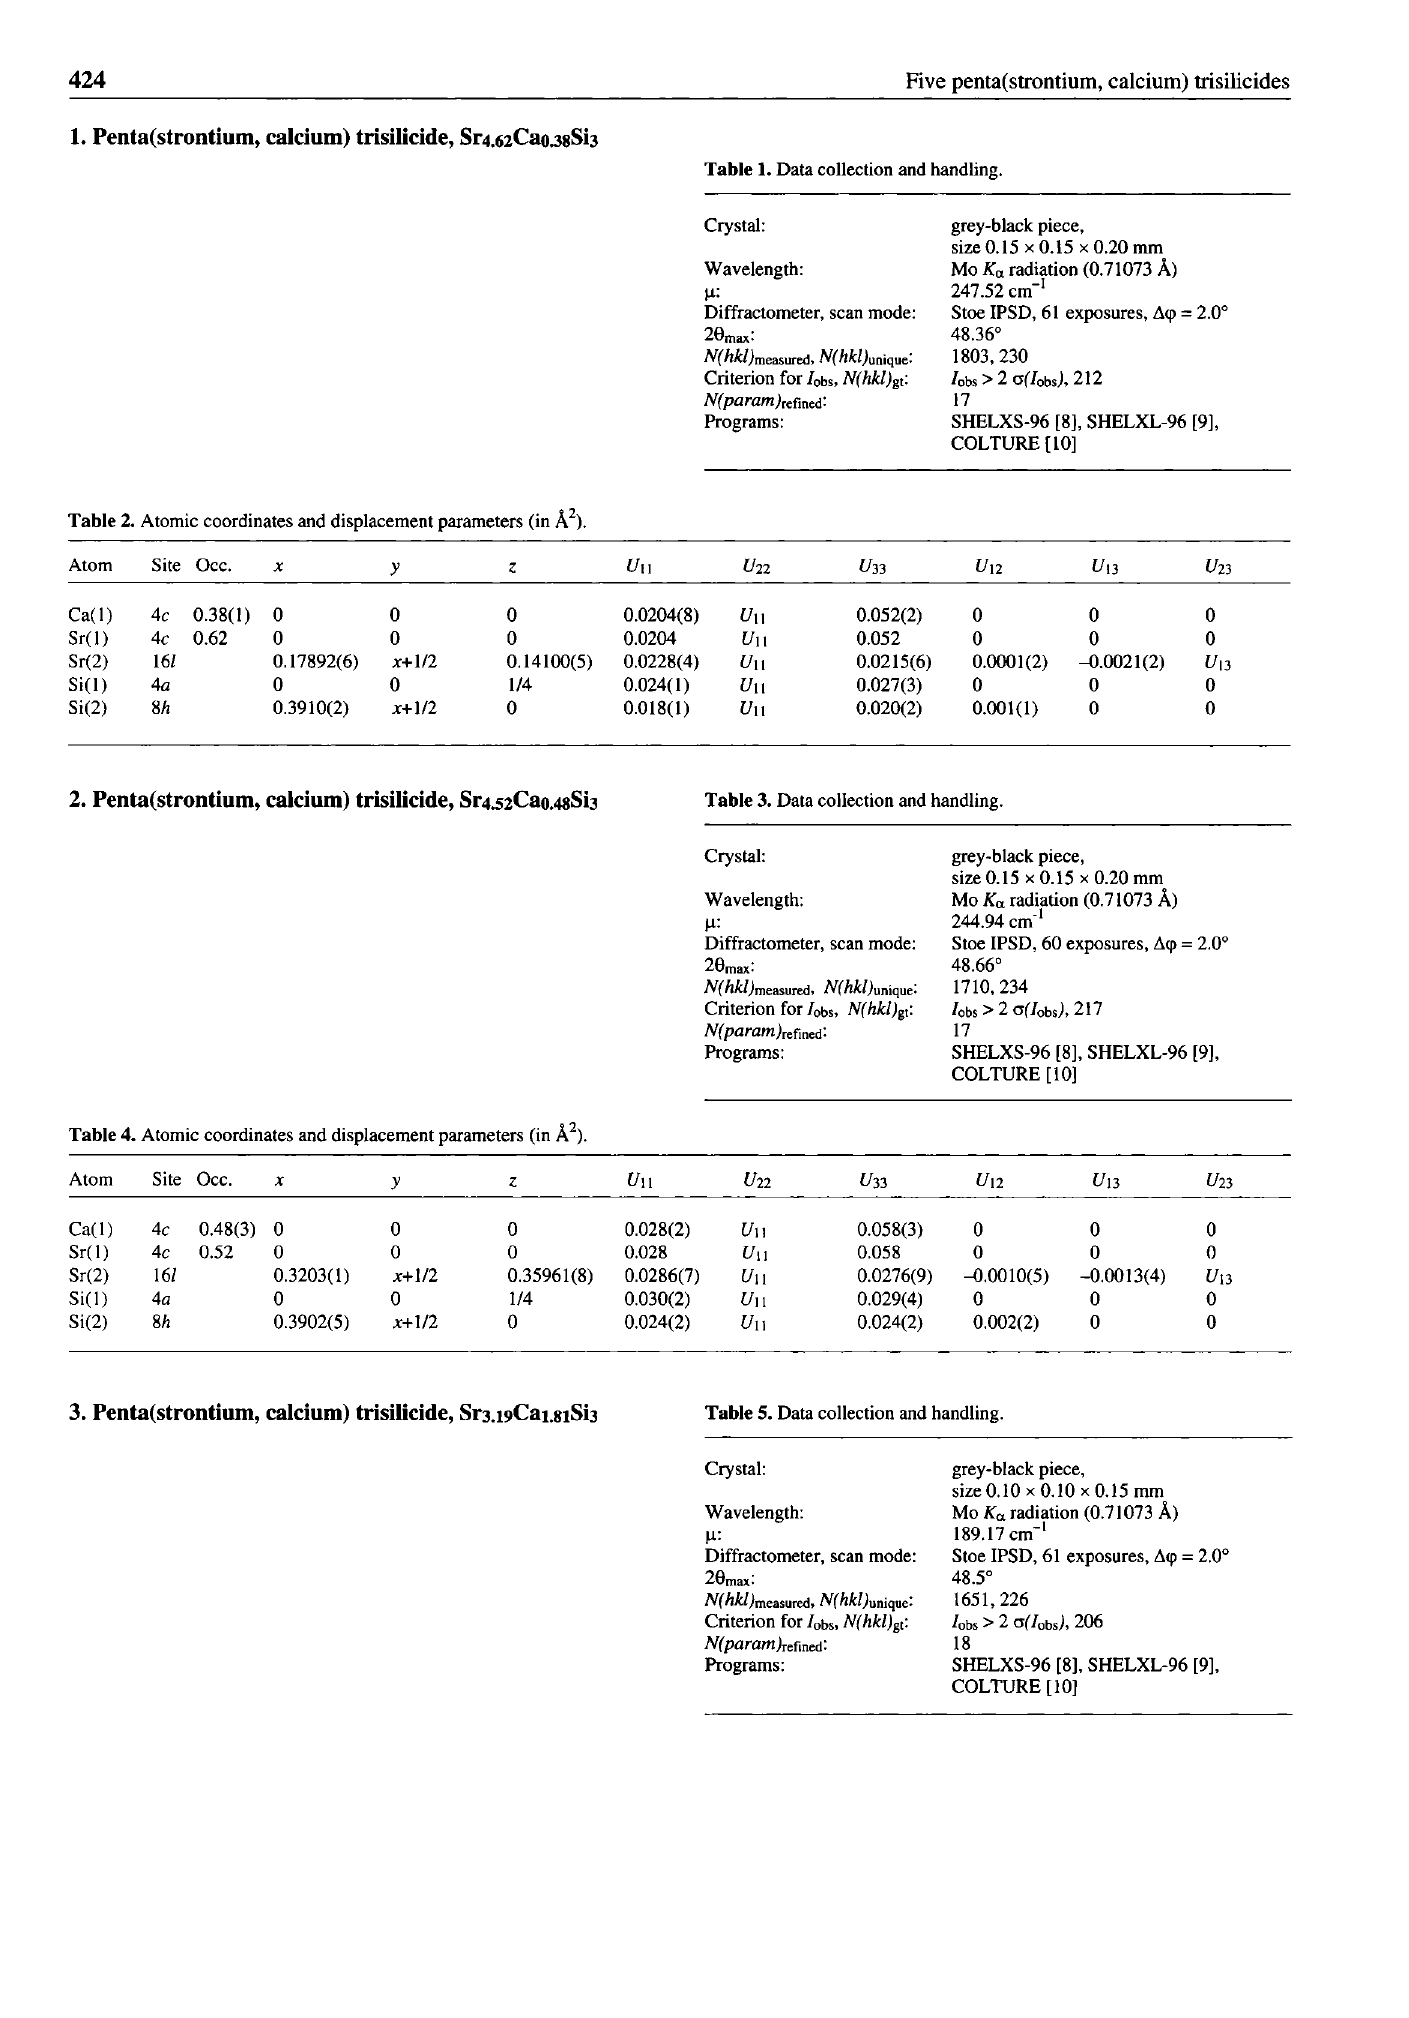
Table 1. Data collection and handling.